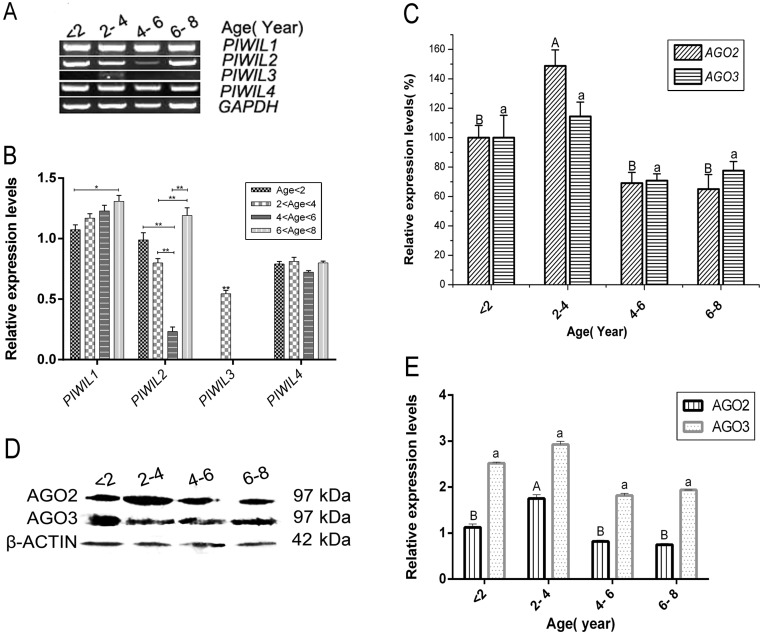
The expression of AGO2 and AGO3 from yak testis during postnatal development. (A) piRNAs expression profile determined by qRT-PCR for Bos grunniens testes samples from <2 year to 6–8 year Chinese Tibet plateau yak. (B) The X-axis represents genes and the Y-axis shows the relative expression levels of RNAs. Data shown are the mean ± s.e. of four groups. Statistical significance was determined by ANOVA followed by Tukey’s post hoc test, and different letters indicate the significant difference. *P ≤ 0.05, **P ≤ 0.01. (C) Data shown are the mean ± s.e. of four groups. Statistical significance was determined by ANOVA followed by Tukey’s post hoc test, different letters indicate significant difference (P < 0.05). (D) Western blot analysis of AGO2 protein and β-actin for samples from animals of different age. (E) The graph shows that the relative amount of AGO2 and AGO3. Data shown are the mean ± s.e. of four groups. Statistical significance was determined by ANOVA followed by Tukey’s post hoc test, and different letters indicate the significant difference (P < 0.05).